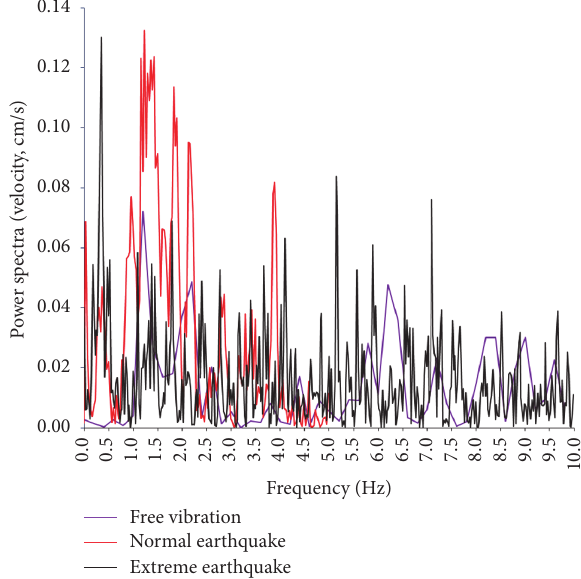
Figure 8: Frequency spectrum for free vibration analysis of the dam and two specific